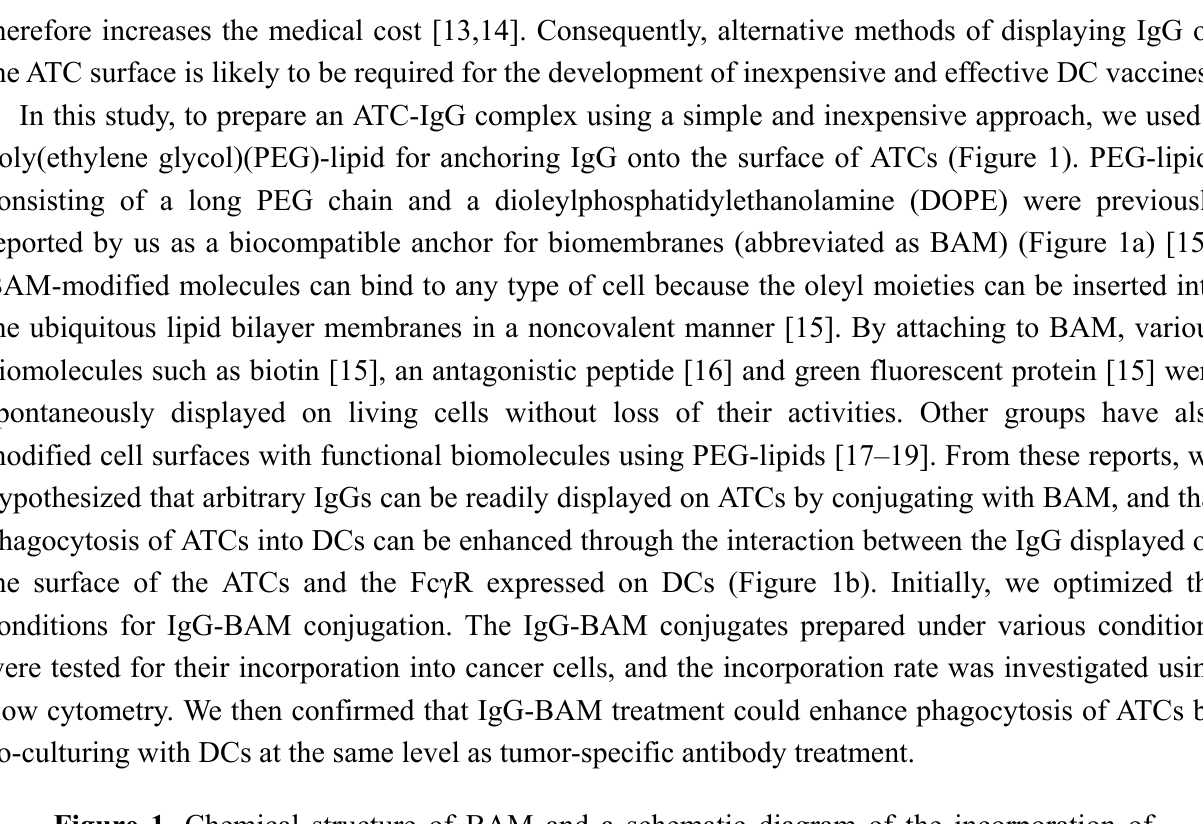
Figure 1. Chemical structure of BAM and a schematic diagram of the incorporation of BAM-conjugated IgG into the cell